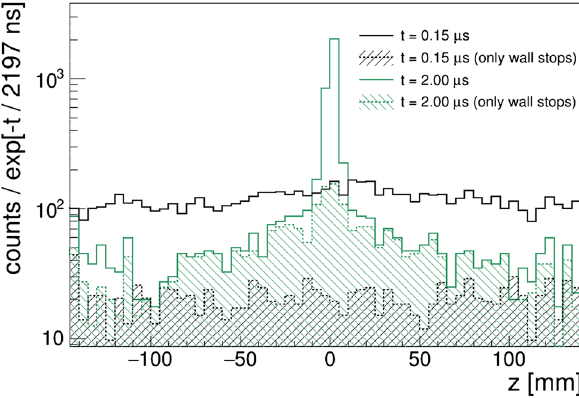
Fig. 3 Simulated muon distribution along the z -axis for various times. The histograms have been corrected for the finite muon lifetime by multiplying the counts with e t / 2197 ns . As can be seen, for t = 2 µ s most of the muons are close to the center of the active region. The shaded areas show the fraction of the μ + that stopped in the walls of the target. At t = 2 µ s, the distribution of the μ + adhering to the target walls is not flat anymore. The reason for the peak around z = 0 is that some of the μ + are scattered into the wall while drifting towards the center of the